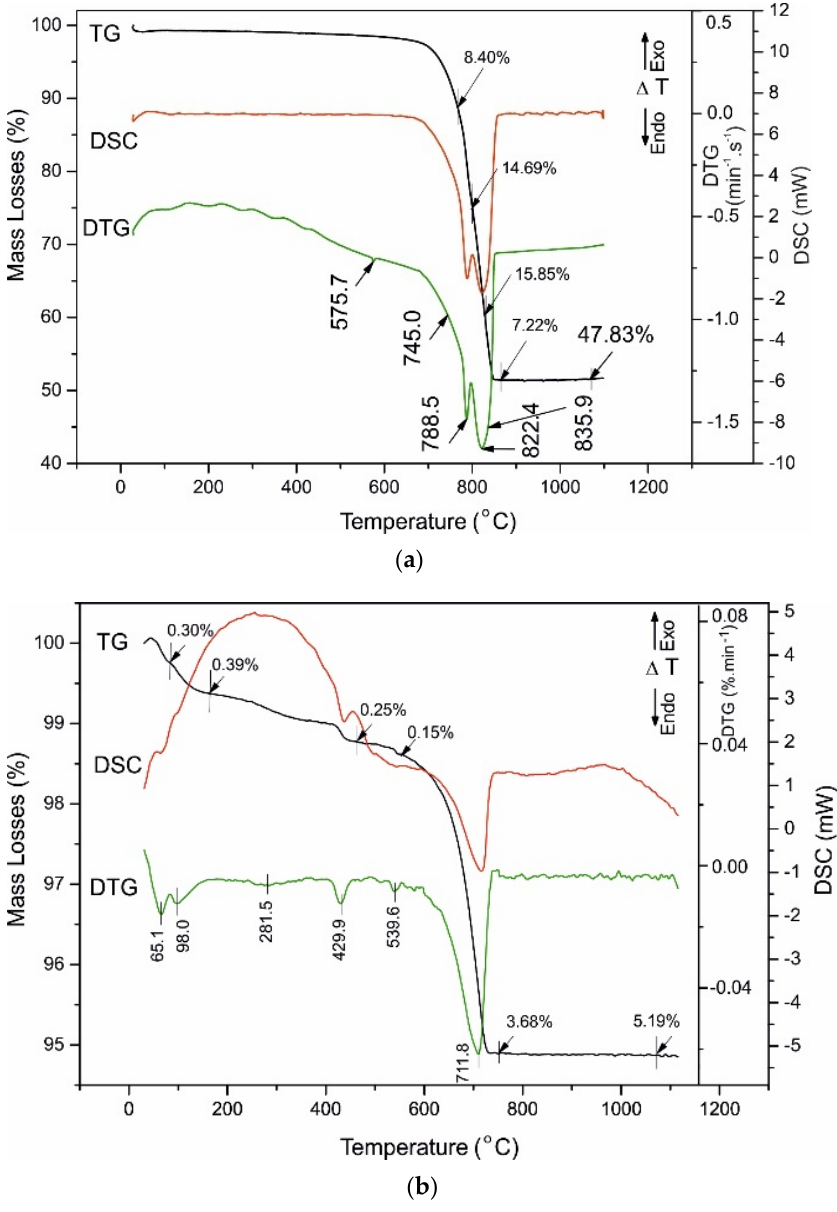
Figure 7. ( a ) TG-DTG-DSC curves of raw aggregate—marble powder. ( b ) TG-DTG-DSC curves of raw white Portland cement.